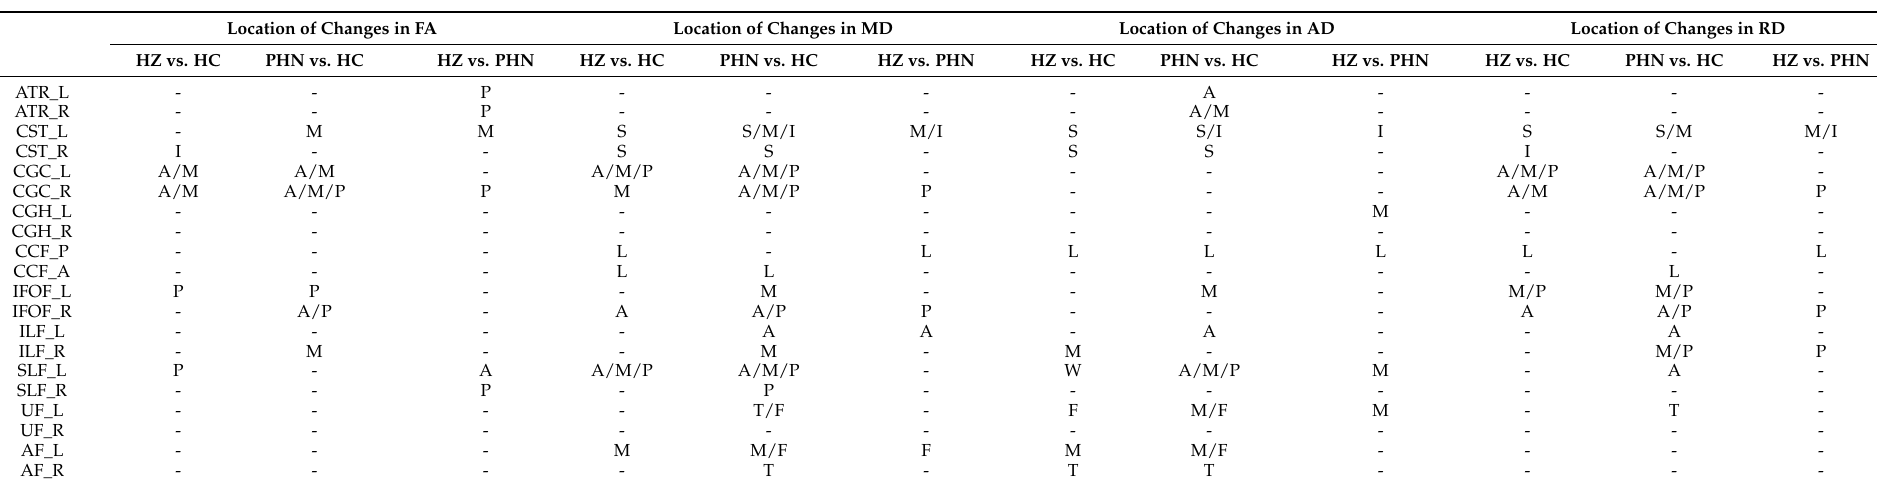
Table 6. Summary of changes in the location of points with significant differences revealed in the pointwise comparison of tract profiles across 20 fiber tracts among the groups. Location of Changes in